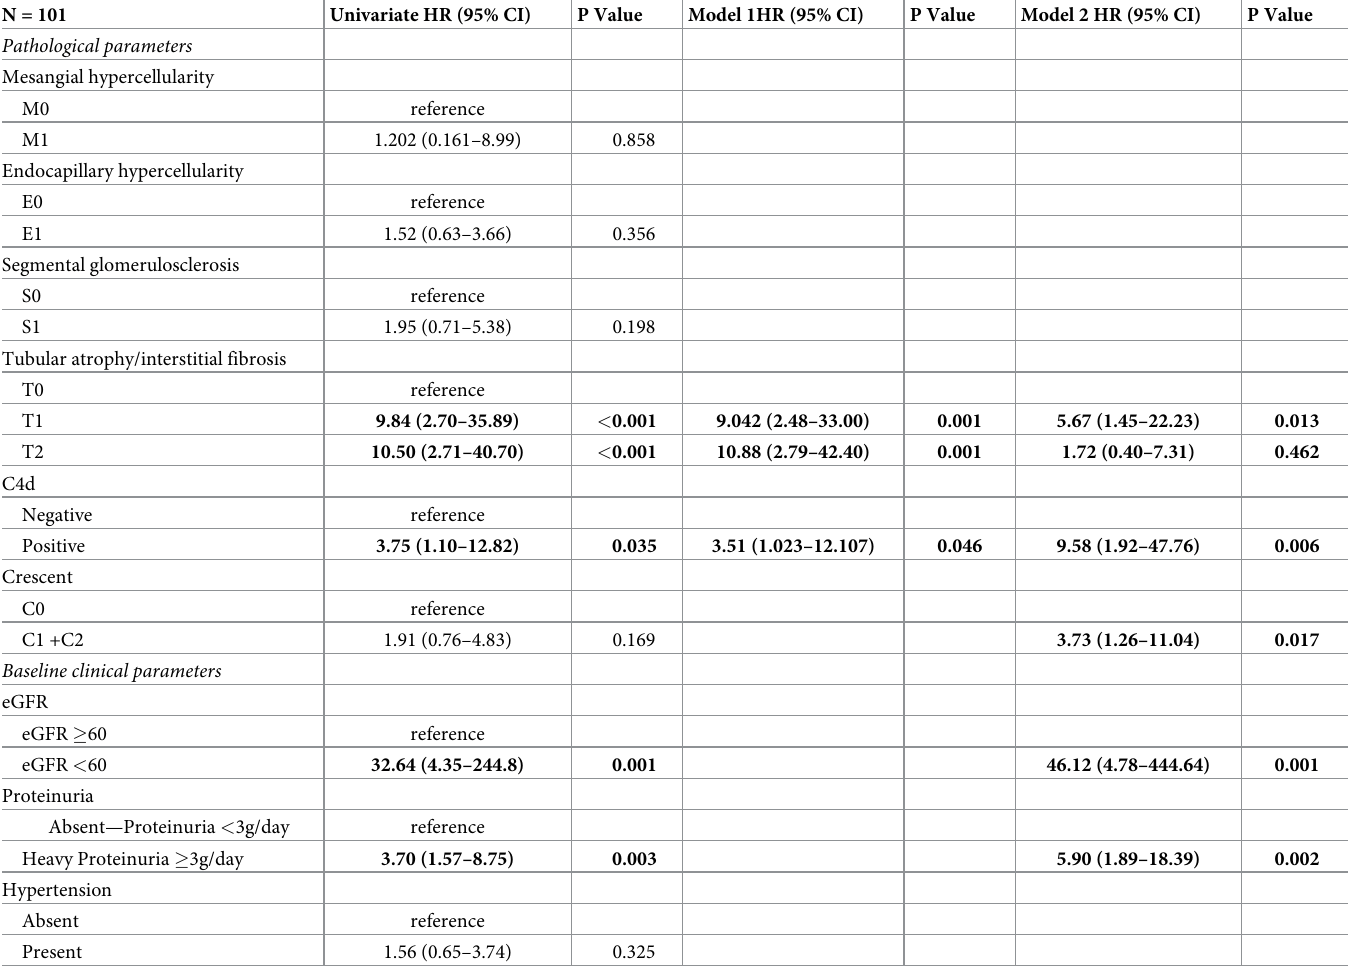
Table 4. Multivariate analysis of clinicopathological parameters on secondary outcome (Kidney